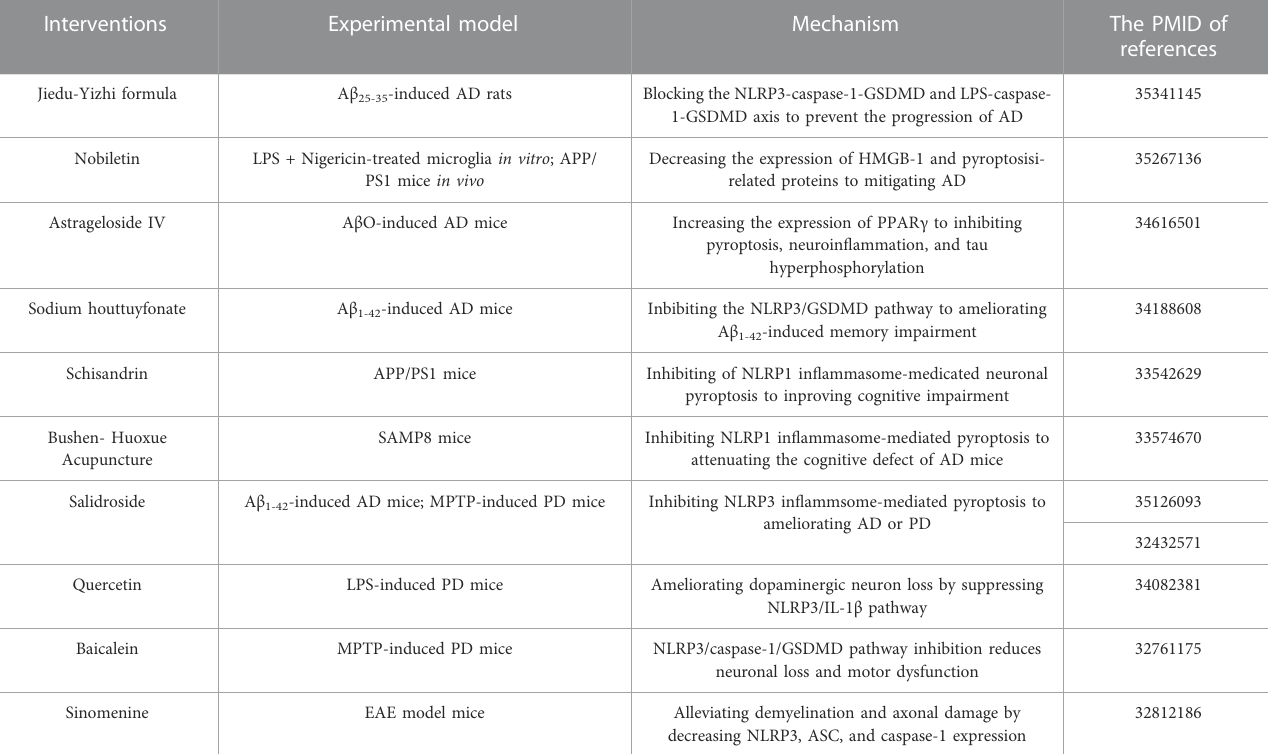
TABLE 2 Treatments targeting pyroptosis in TCM for neurodegenerative diseases.